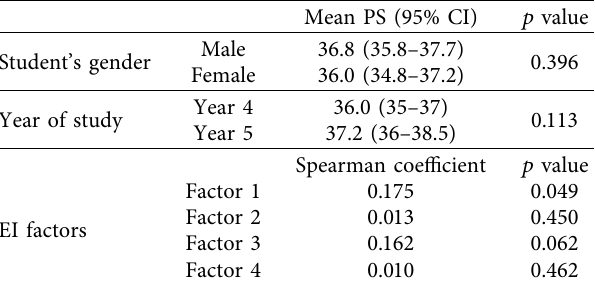
Table 3: Association between dental undergraduate’s gender, year of the study, EI scores, and PS. Mean PS (95%